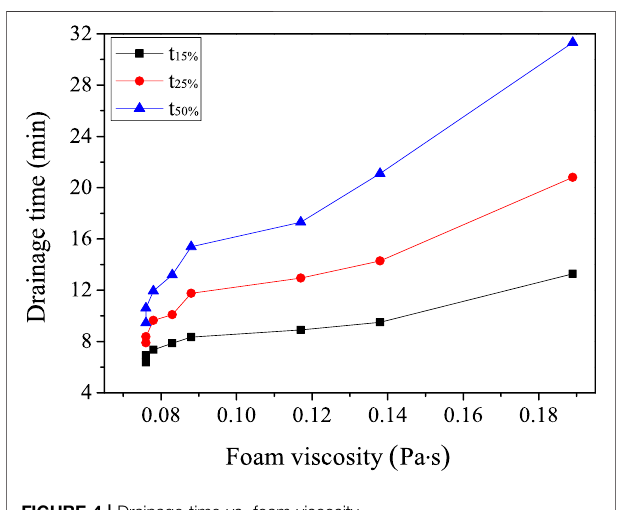
FIGURE 4 | Drainage time vs. foam viscosity.